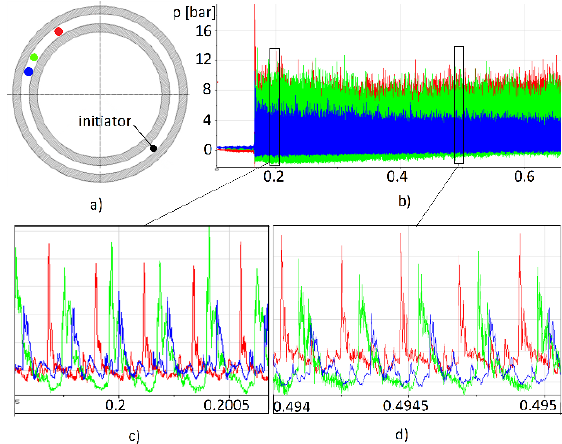
Fig. 9. The example of an experiment with the use of the initiator close to the small eccentricity, a) schematic of the cross section of the annular detonation chamber with colored points of located pressure transducers and indication of the position of the initiator, b) recorded pressure by the three transducers, c, d) enlarged randomly selected pressure records. More detailed description of this research can be found in [33]